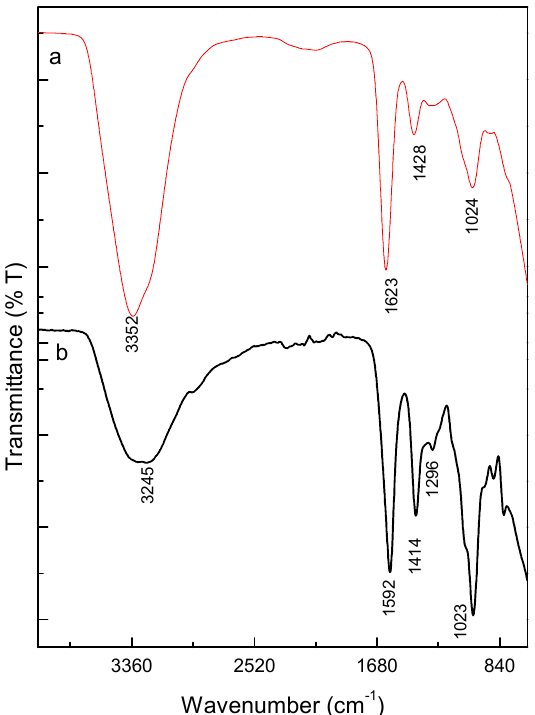
Micromachines 2022 , 13 , x Figure 4. ATR-FTIR spectrum of ( a ) Alg and ( b ) Alg/Gel microgels. Figure 4. ATR – FTIR spectrum of ( a ) Alg and ( b ) Alg/Gel microgels.